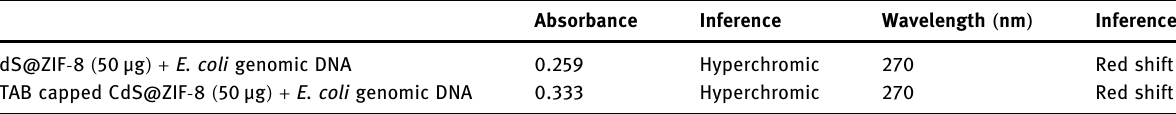
Table 3: DNA - binding studies of CdS@ZIF - 8 and CTAB - capped CdS@ZIF -